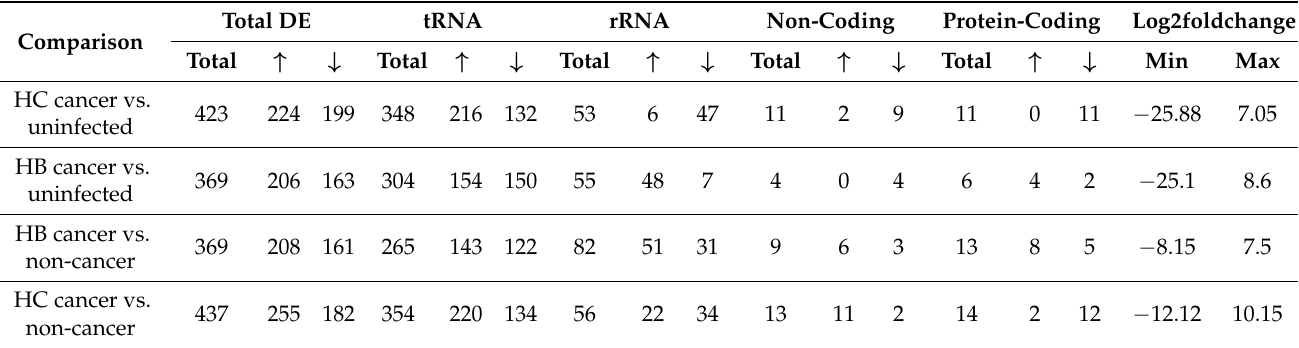
Table 1. Differentially expressed (DE) mt-sRNAs ( p -adj < 0.1) in pairwise comparisons of datasets generated by [18] (dataset-1). Liver samples ( n = 4 for each group) were obtained from subjects suffering chronic hepatitis C (HC) or hepatitis B (HB), with either diagnosed hepatocellular